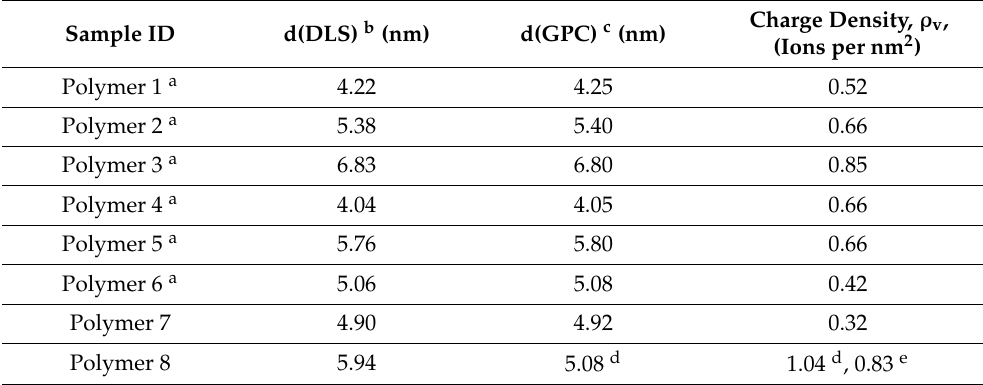
Table 3. Measured and calculated particle size (diameter) and charge density of the